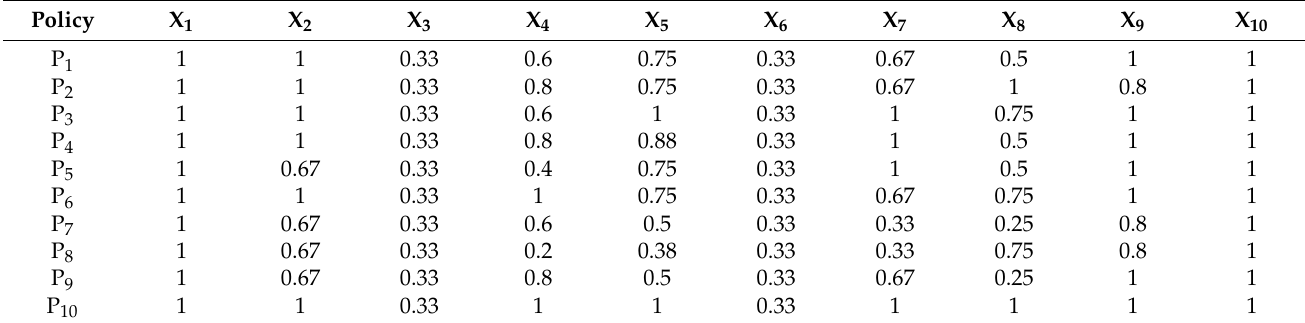
Table 5. Results of PMC-Index.